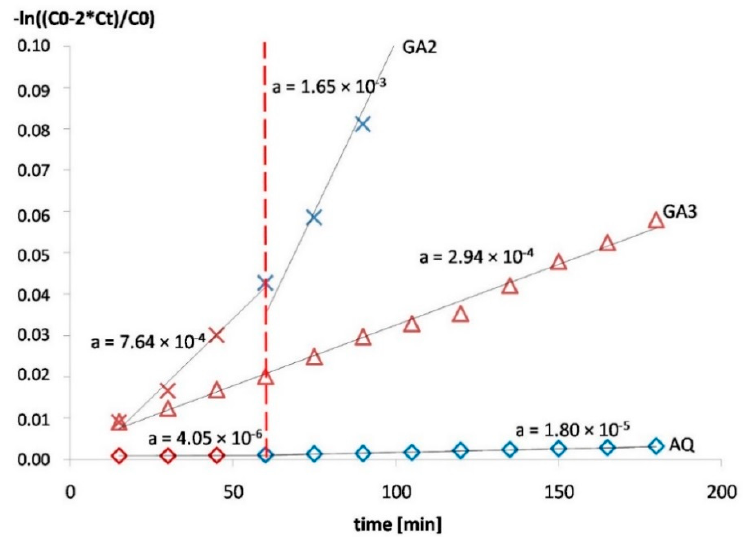
Figure 5. Permeation rate of T 2 O through GA2 (25% Aquacoat), GA3 (25% Aquacoat, 1.5% carrageenan) and AQ (pure Aquacoat CPD) films. The slopes for different experiments are fitted and the “a” values for the slopes are indicated in the graph.